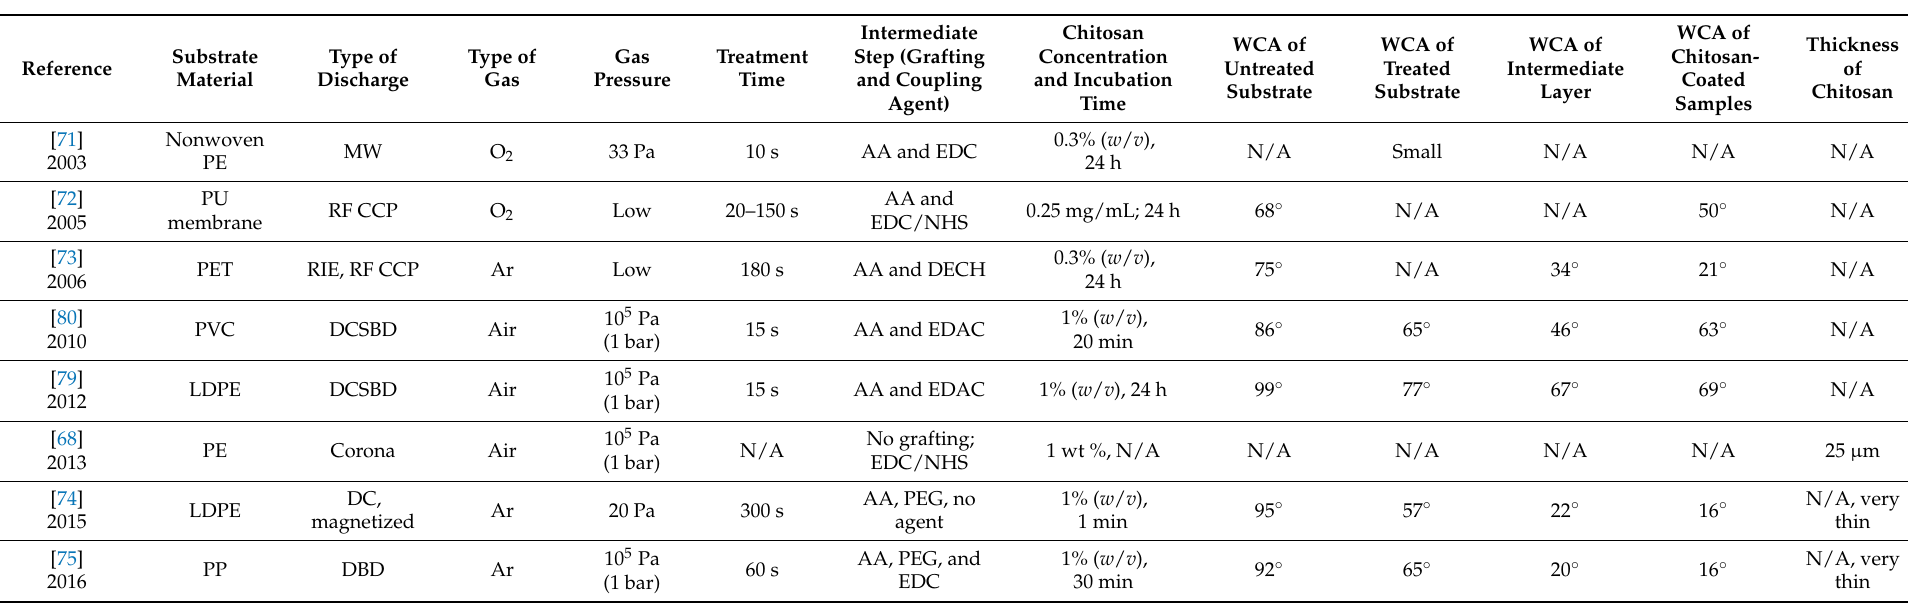
Table 2. Summary of processing parameters and surface finish reported for chitosan immobilization on plasma-treated substrates via an intermediate layer